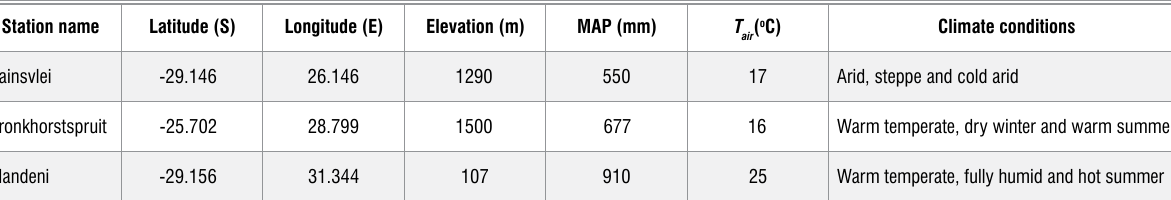
) at three weather air